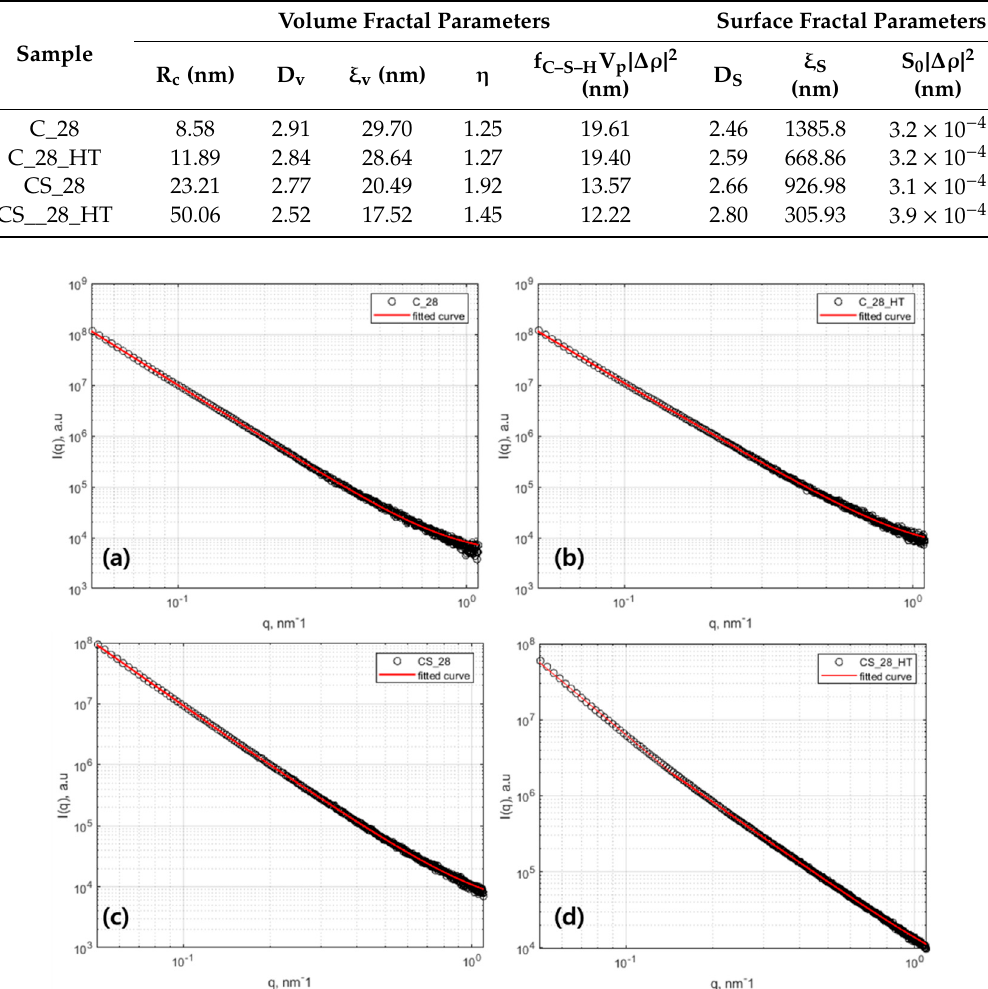
Table 4. Volume and surface fractal parameters derived from SAXS fitting of the fractal model.